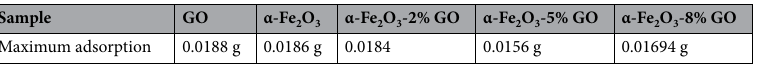
Table 1. Maximum adsorption of different weight percentages of GO nanocomposites during 60 min maintained in dark room.